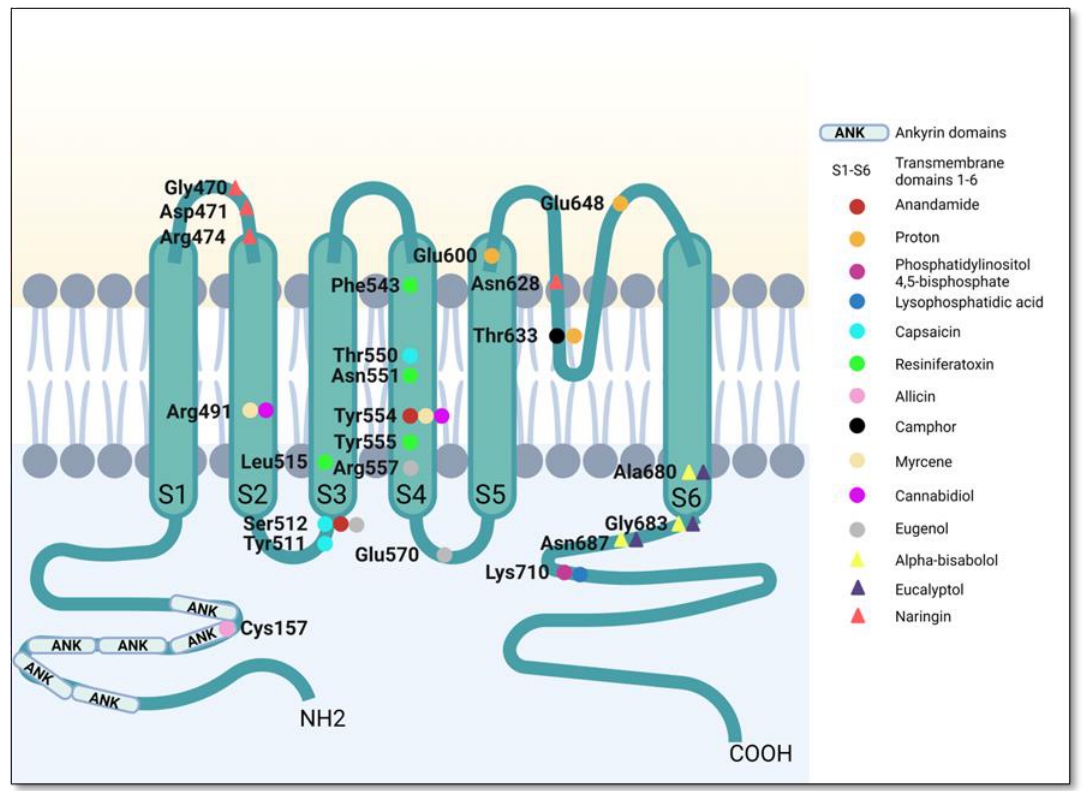
Figure 6. Main interactions of TRPV1 modulators.